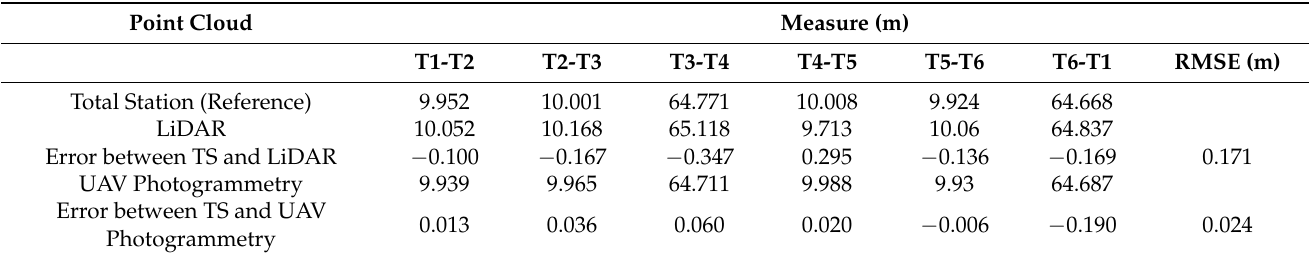
Table 11. Distance errors between the LiDAR and UAV photogrammetry